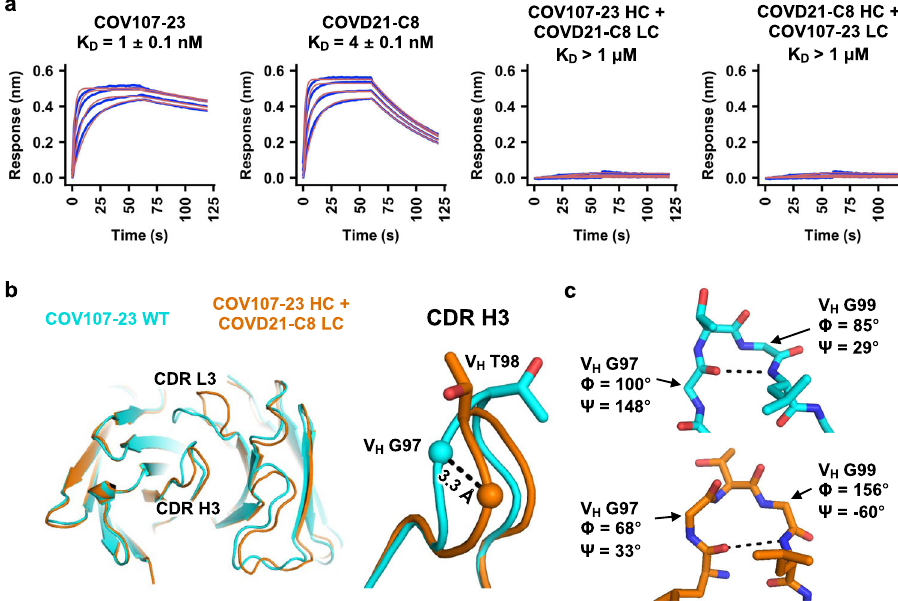
Fig. 3 Speci fi c pairing of CDR H3 and light chain is critical for IGHV3-53/3-66 antibody binding to SARS-CoV-2 RBD. a Binding of different Fabs to SARS-CoV-2 RBD was measured by biolayer interferometry with RBD loaded onto the biosensor and Fab in solution. Y -axis represents the response. Dissociation constant ( K D ) for each Fab was obtained using a 1:1 binding model, which is represented by the red curves. COV107-23 belongs to clonotype 1, whereas COVD21-C8 belongs to clonotype 2. b Fab crystal structures of wild-type (WT) COV107-23 and COV107-23 heavy chain pairing with COVD21- C8 light chain are compared. Left panel: structural alignment using residues 1 – 90 of the heavy chain. Right panel: Zoomed-in view for the CDR H3. c Conformations at the tips of the CDR H3s in WT COV107-23 and COV107-23 heavy chain pairing with COVD21-C8 light chain are shown. A β -turn is observed in CDR H3 of WT COV107-23, with V H G97 and V H G99 at the i and i + 2 positions, respectively. V H indicates residues belong to the heavy